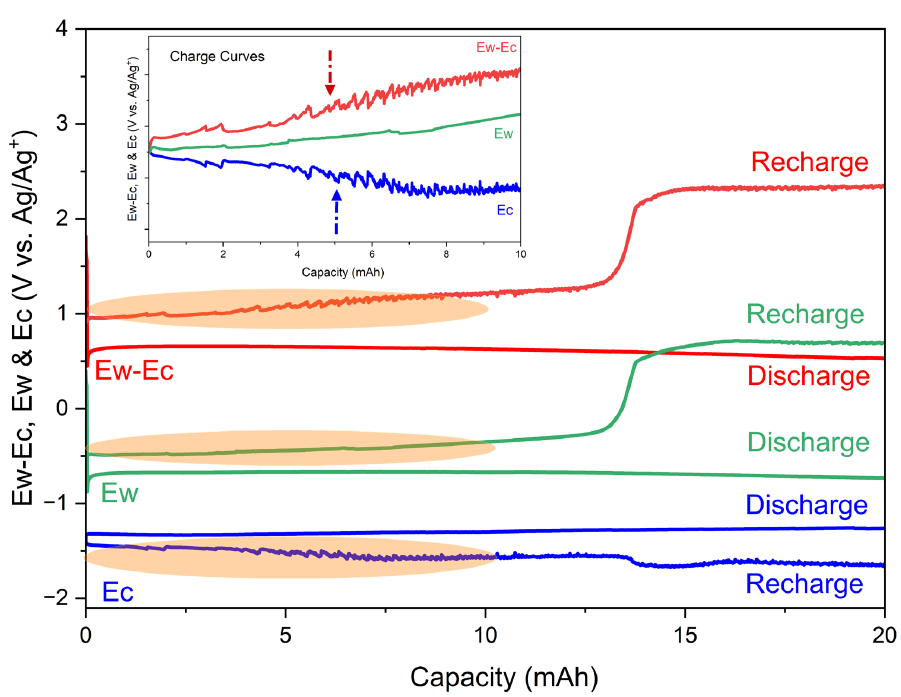
Figure 4. Galvanostatic Discharge/Charge plot for a Zn/Bi 2 O 3 battery showing separately the working electrode (Ew), counter electrode (Ec), and the entire battery (Ew–Ec) curves vs. capacity. The working electrode was Bi 2 O 3 and the counter was Zn electrode. Ag wire was used as pseudo-reference electrode. Electrolyte: ⁓ 1 mL of 8 M KOH solution. In this figure, only the first cycle is shown. Inset: Details of the three curves until capacity of 10 mAh (curves were shifted to better comparison).